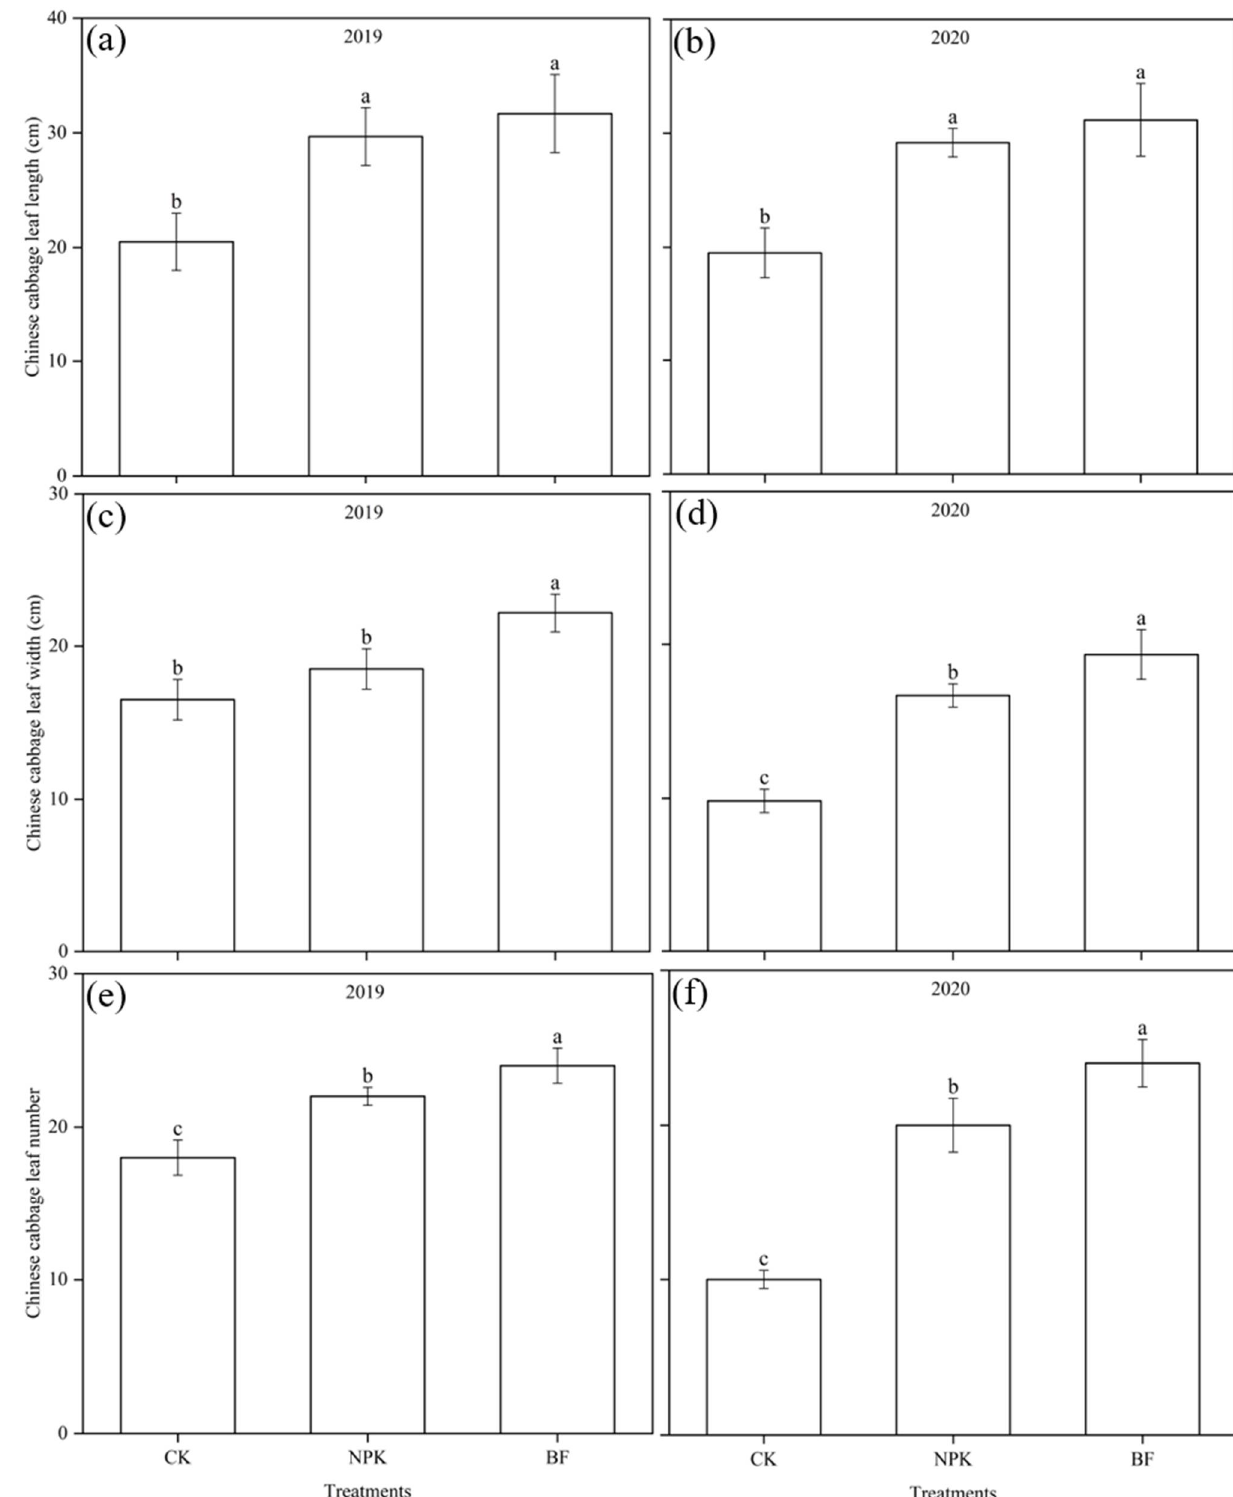
Figure 3. Growth-related traits of Chinese cabbage in 2019–2020 under different N treatments. ( a ), Leaf length of Chinese cabbage in 2019. ( b ), Leaf length of Chinese cabbage in 2020. ( c ), Leaf width of Chinese cabbage in 2019. ( d ), Leaf width of Chinese cabbage in 2020. ( e ), Leaf number of Chinese cabbage in 2019. ( f ), Leaf number of Chinese cabbage in 2020. The error bars show standard deviations of the means (n = 3). Different lowercase letters indicate significant differences among treat- ments ( p < 0.05).